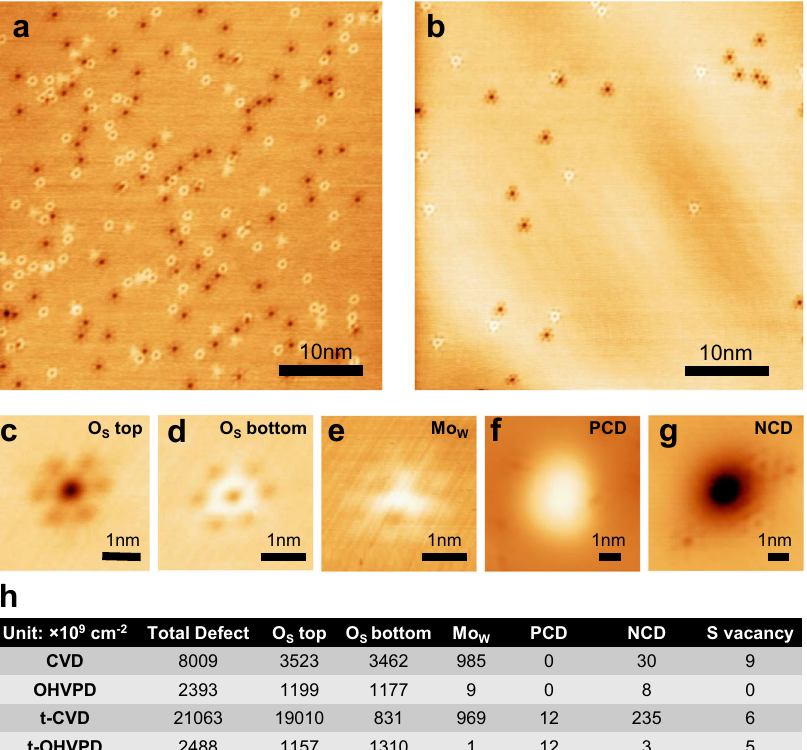
Fig. 3 Defect analysis by scanning tunneling microscopy (STM). a , b STM images of a CVD-WS 2 (Bias Voltage (V) = 1.35 V, Current (I) = 40 pA) and b OHVPD-WS 2 monolayer (V = 1.15 V, I = 30 pA). c – f STM images (V = 1.1 V, I = 30 pA) of the commonly observed point defects in CVD- and OHVPD- WS 2 : oxygen substituting sulfur (O s ) in the c top and d bottom sulfur plane; e Mo substitutional tungsten (Mo W ); f Positively charged defect (PCD) and g Negatively charged defect (NCD). h , Histograms table of observed point defect density in different OHVPD- and CVD- WS 2